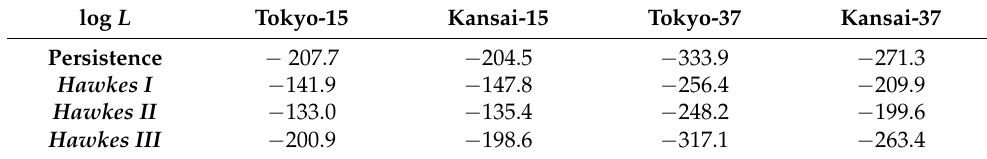
Table 2. Values of the log-likelihood log L corresponding to the four investigated models. log L Tokyo-15 Kansai-15 Tokyo-37 Kansai-37 Persistence − 207.7 − 204.5 Hawkes